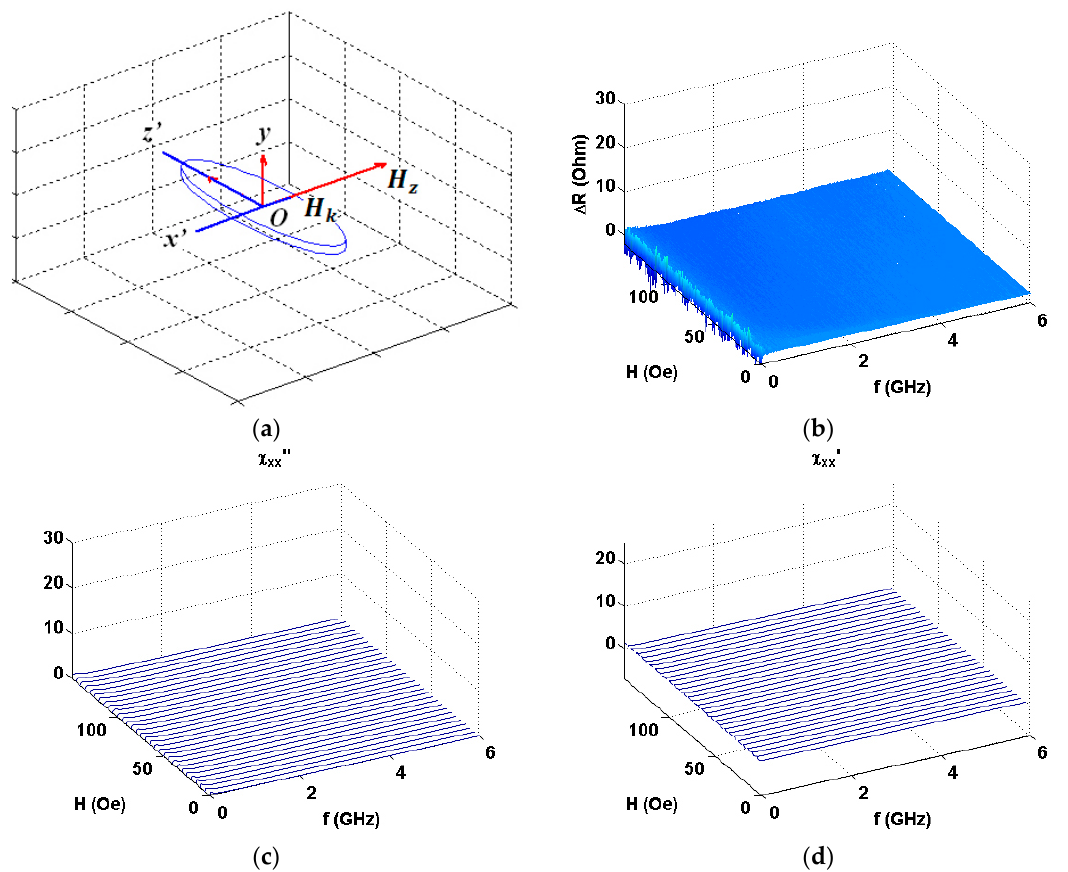
Figure 7. Coordinate system for vector H directed under the angle α = 0° with respect to high frequency field h ( a ). Experimental data for the applied field and frequency dependences of the imaginary part ( b ) of the impedance of GMI element. Model calculations for imaginary ( c ) and real ( d ) parts of the susceptibility tensor corresponding to the imaginary and real parts of the impedance variations.